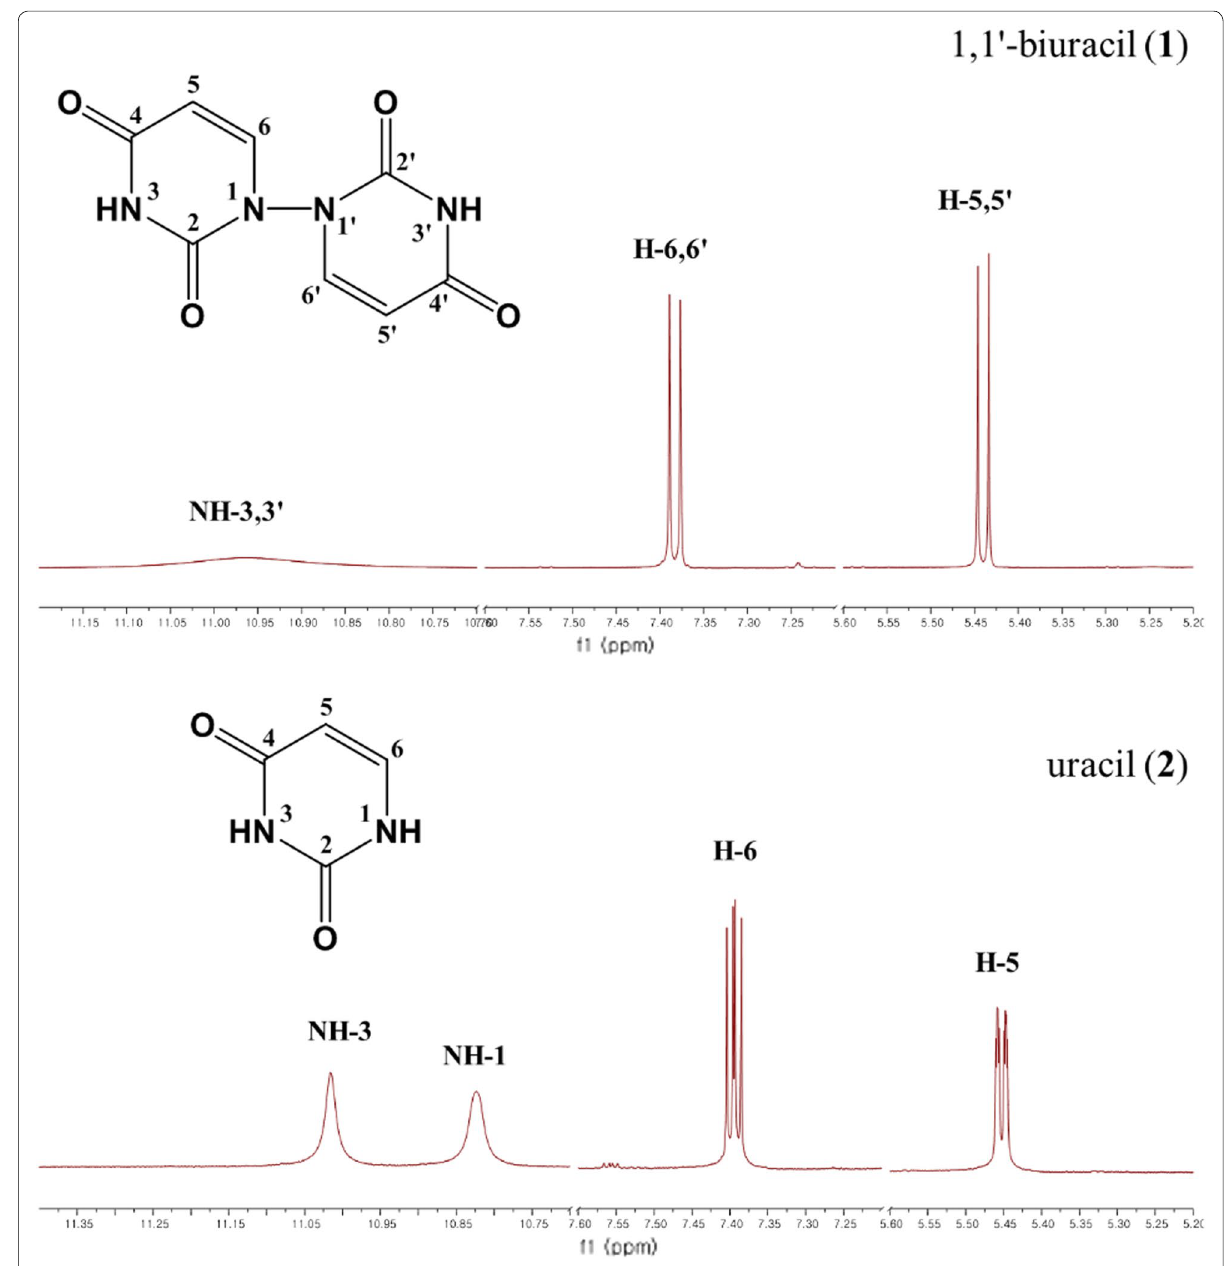
Fig. 2 1 H‑NMR spectrum of 1,1 ′ ‑biuracil ( 1 ) and uracil ( 2 ) (600 MHz, DMSO‑ d 6